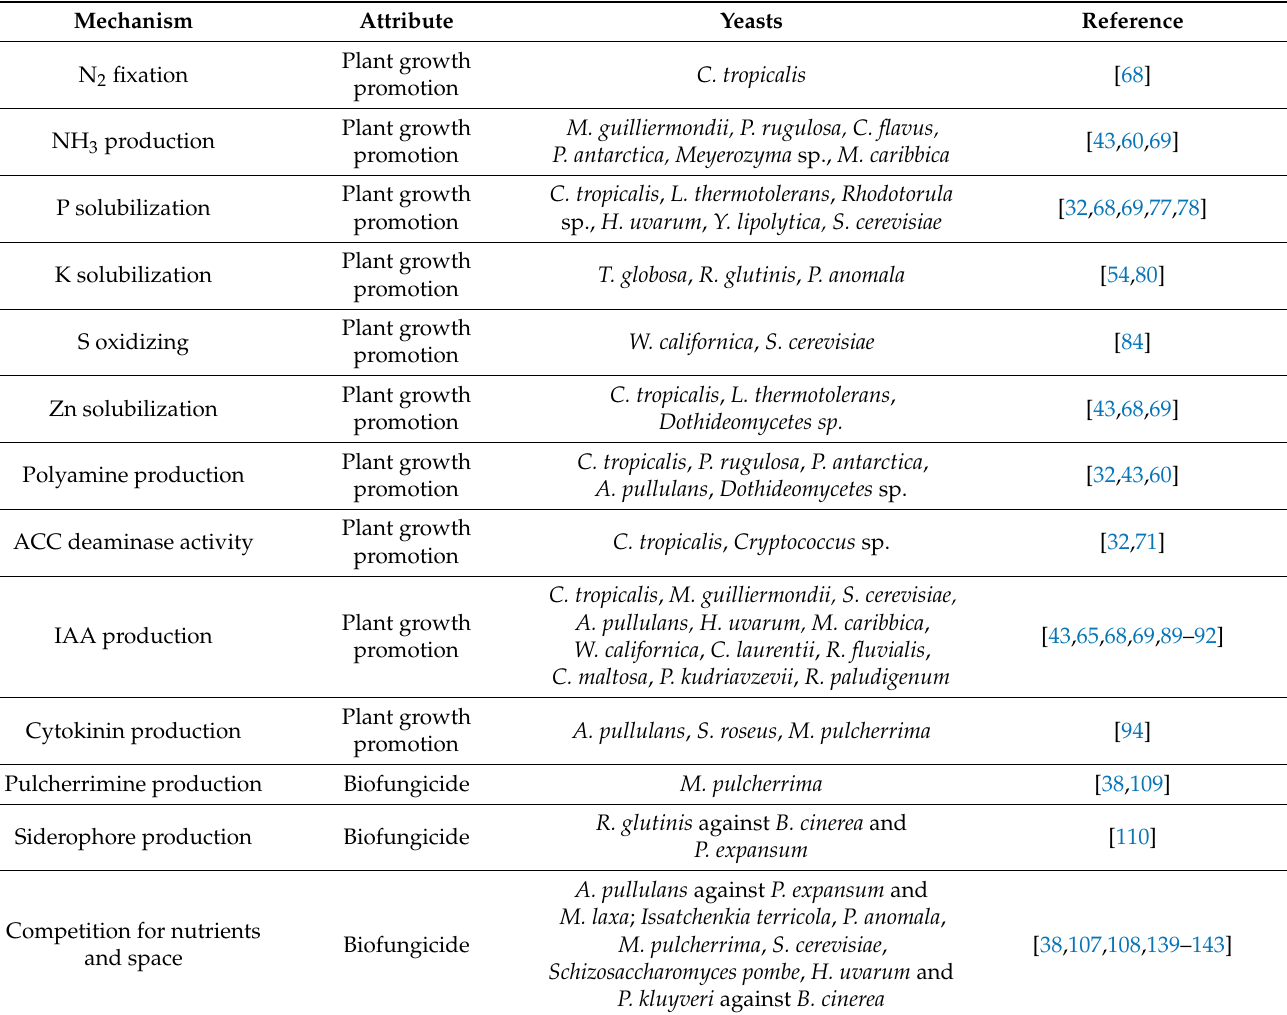
Table 1. Applications of yeasts as plant growth promoters, biofungicides, bioinsecticides or biodegraders. Mechanism Attribute